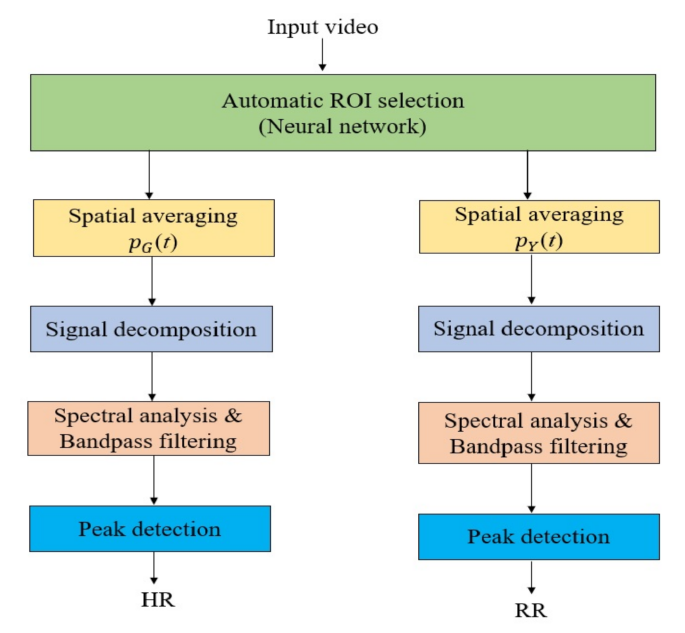
Figure 2. The system framework consists of two branches to detect heart rate and respiratory rate. The input video was processed for automatic ROI detection, and the ROI was processed separately for heart rate and respiratory rate